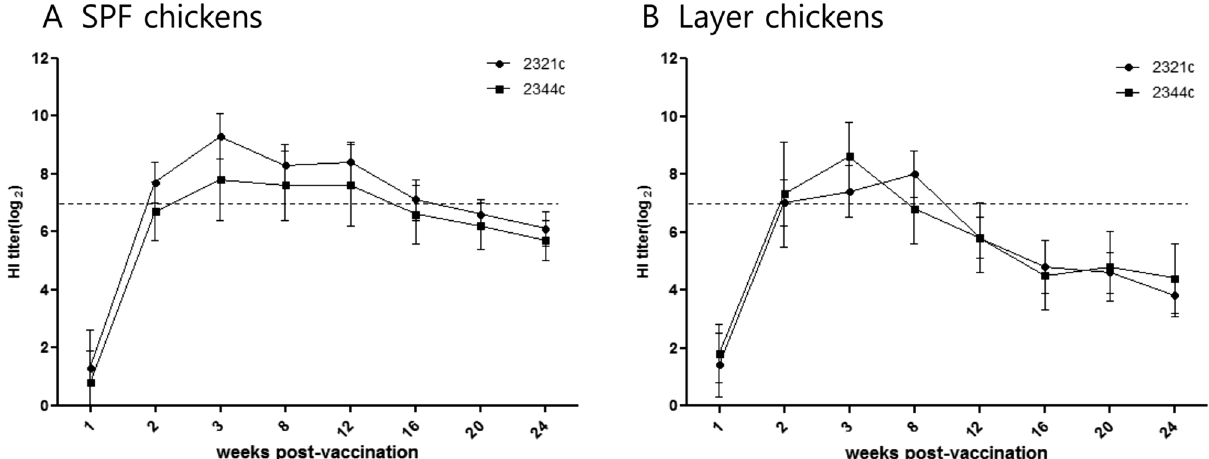
Figure 5. Antibody persistence following administration of one dose (512 HAU) of vaccine. ( A ) SPF chickens. ( B ) Layer chickens. Hemagglutination inhibition (HI) assay titers were determined up to 24 weeks post- vaccination. Titers are expressed as log 2 values. The horizontal dotted line indicates a HI titer of 7 log 2 , which is the standard threshold for preventing virus